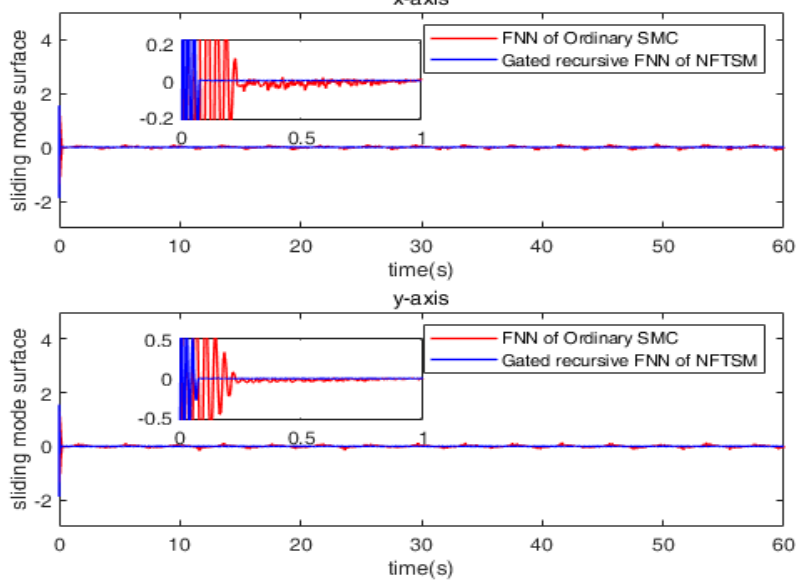
Figure 13. Comparison of the sliding surface between NFTSMC ‐ GRFNN and SMC ‐ FNN.